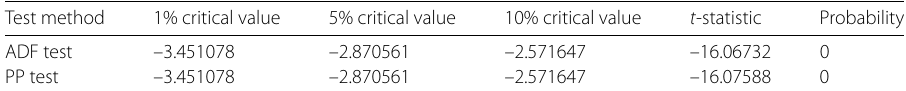
Table 2 Stationary test